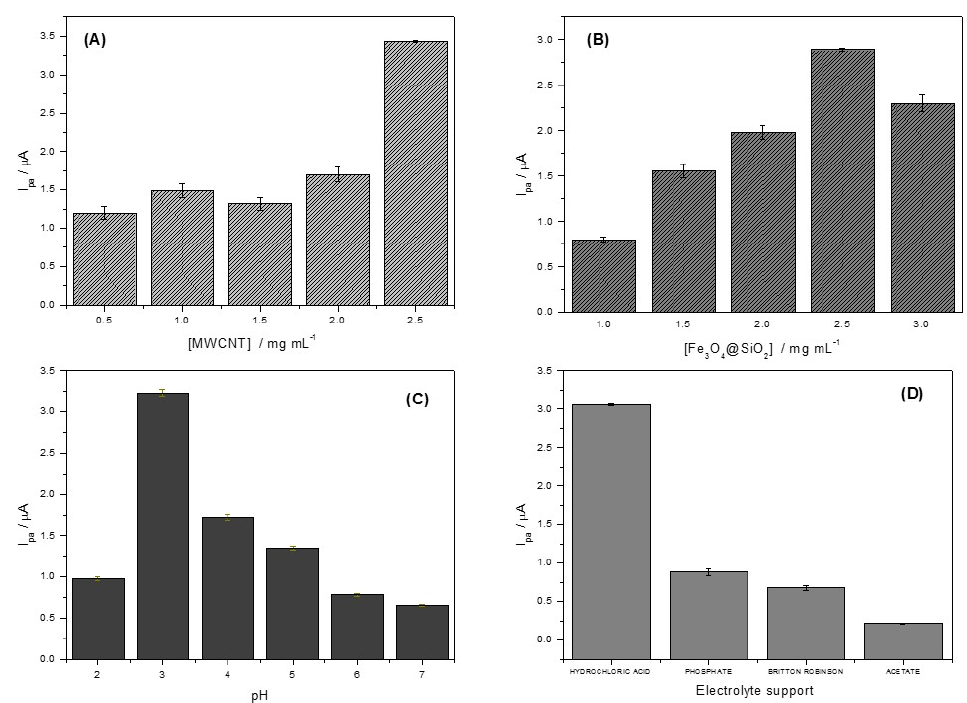
Figure 8. Optimization of the electrochemical parameters of the sensor. Effects of ( A ) amount of MWCNT and ( B ) amount of Fe 3 O 4 @SiO 2 , ( C ) pH, and ( D ) composition of electrolyte support. Scan rate 25 mV s − 1 and potential range between 0 and 0.40 V.